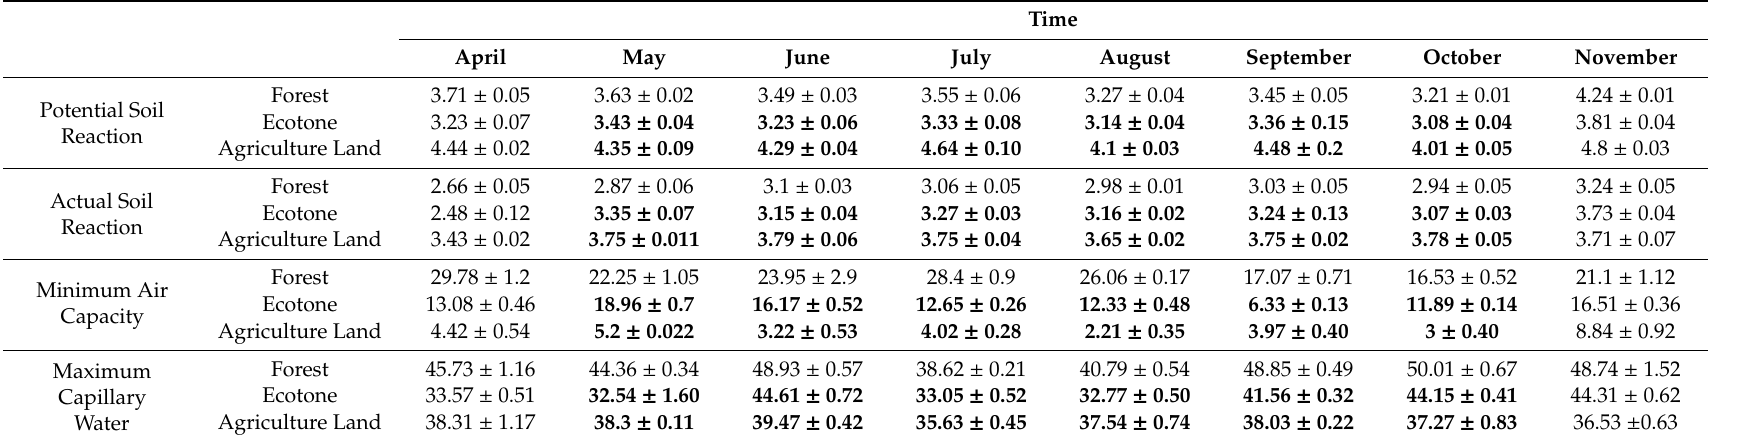
Table 2. Variation of selected soil properties across the forest ecotone agriculture land during the year. Data represent means and errors (mean ± SE, n = 3 − 9). Significant di ff erences within each time are indicated in the bold script (in a column) (One-way ANOVA followed by Tukey post hoc test, p <